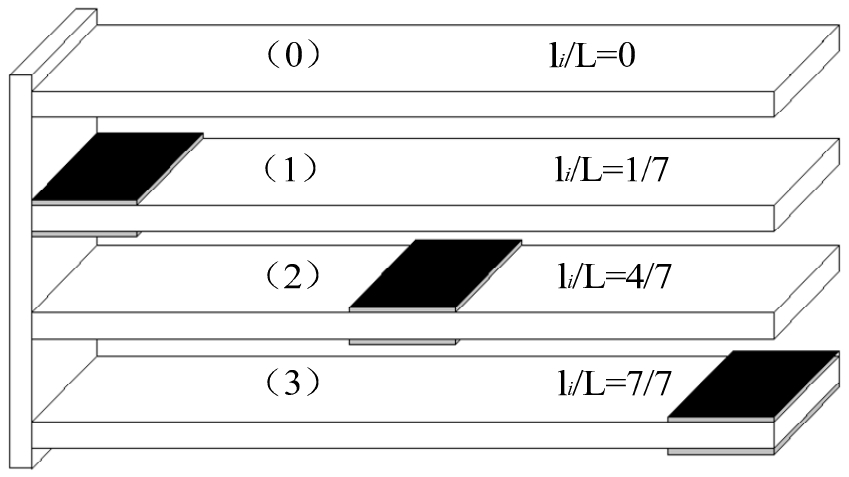
Figure 3. Cantilever plate structures with piezoelectric layers arranged in different